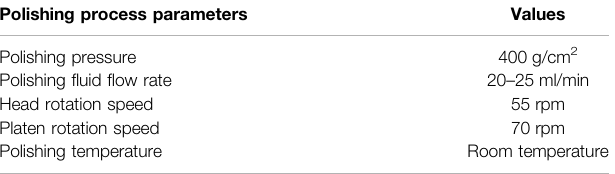
TABLE 1 | Polishing process parameters. Polishing process parameters